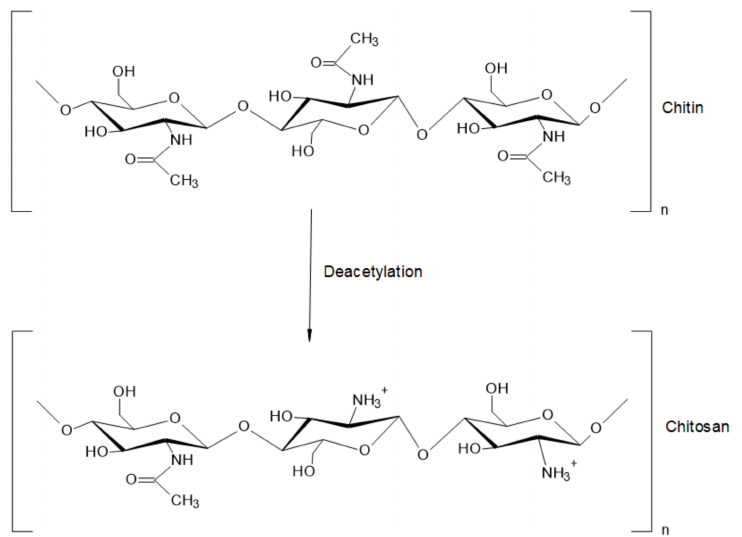
Figure 2. Structure of chitin and chitosan.